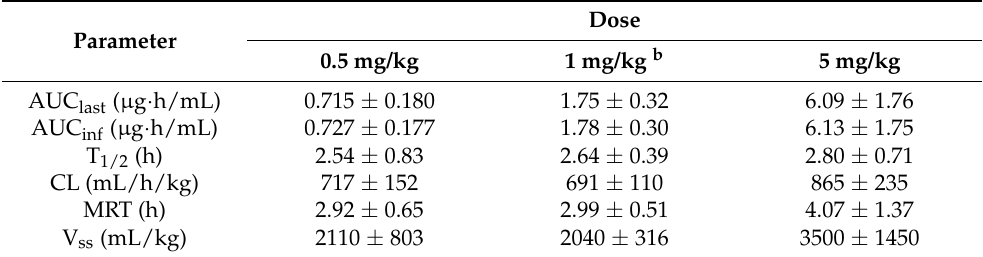
Table 1. Pharmacokinetic parameters of supinoxin after intravenous administration a